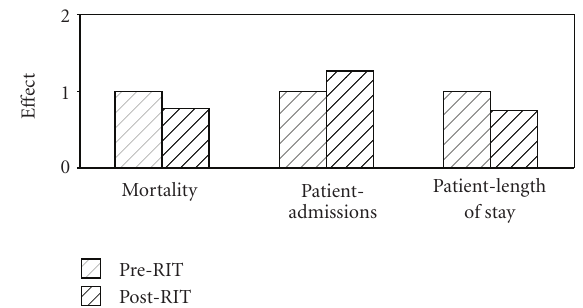
Figure 3: Average impact as extracted from hospitalisation case